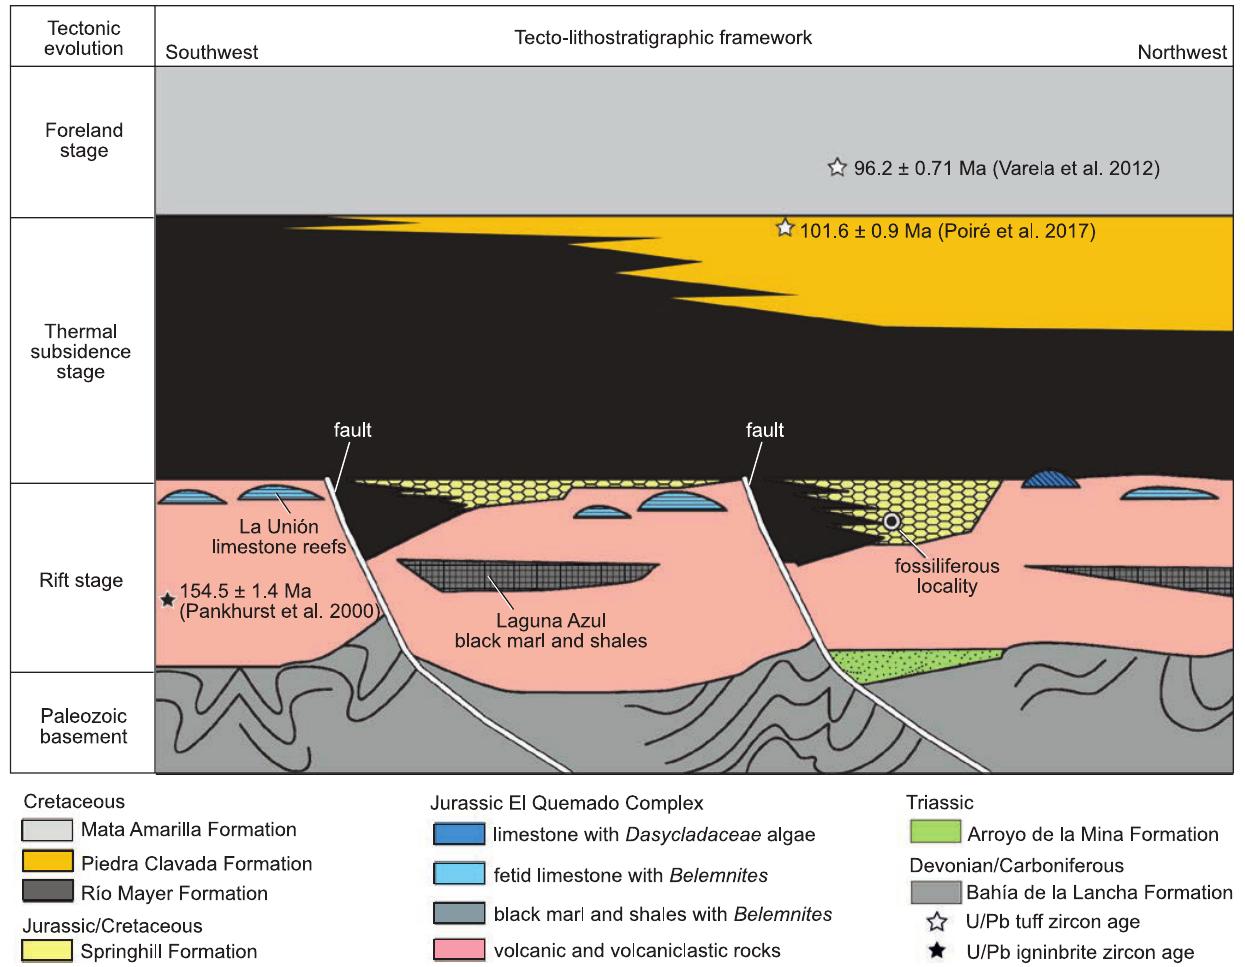
Fig. 3. Trunk location in the tecto­stratigraphic framework of the initial infilling of the Austral­Magallanes Basin, from the rift stage to the beginning of the foreland stage (modified from Poiré et al. 2017). Not to